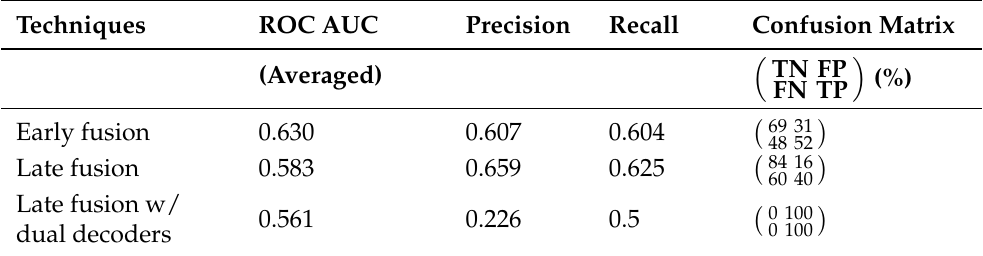
Table 2. Results for different fusion techniques on our multi-perspective dices dataset. The ROC AUC values are averaged over three experiments which were run with different seed values. True positive samples (TP) are anomalous,